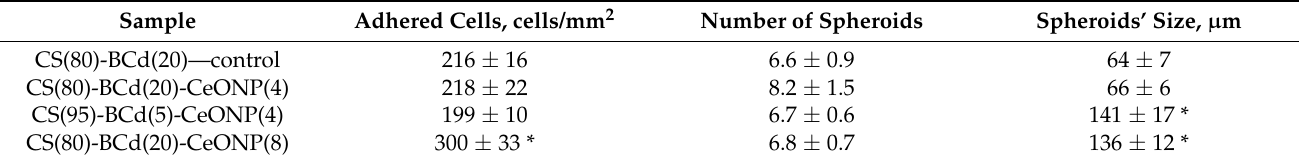
Table 4. Adhesion of the human mesenchymal stem cells (MSCs) on the samples